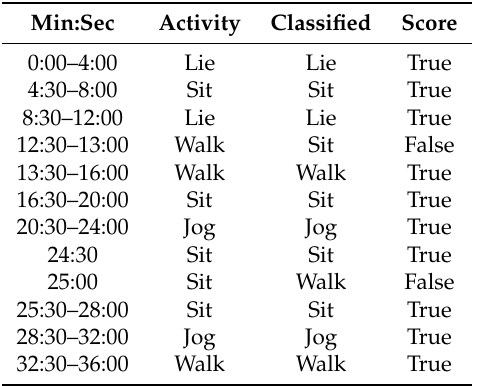
Table 7. Table of results of the implementation